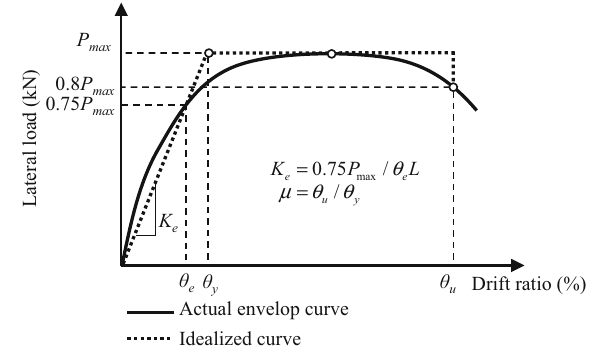
Fig. 17 Definition of drift ratios in idealized backbone